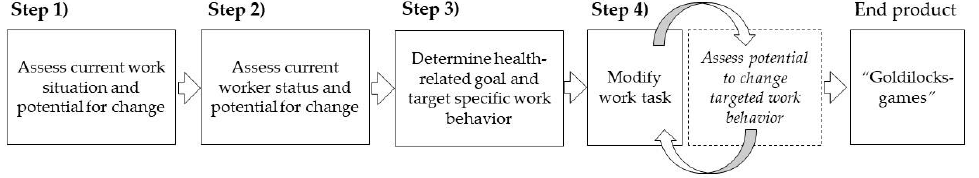
Figure 1. The process of designing the Goldilocks-games following the 4-steps of the Goldilocks